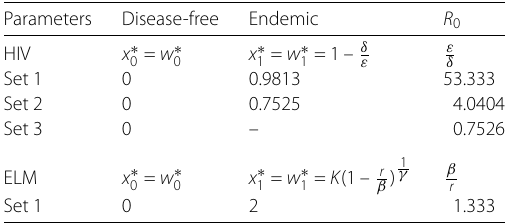
Table 10 Values of equilibrium points and R 0 of HIV and ELM models from Tables 8 and